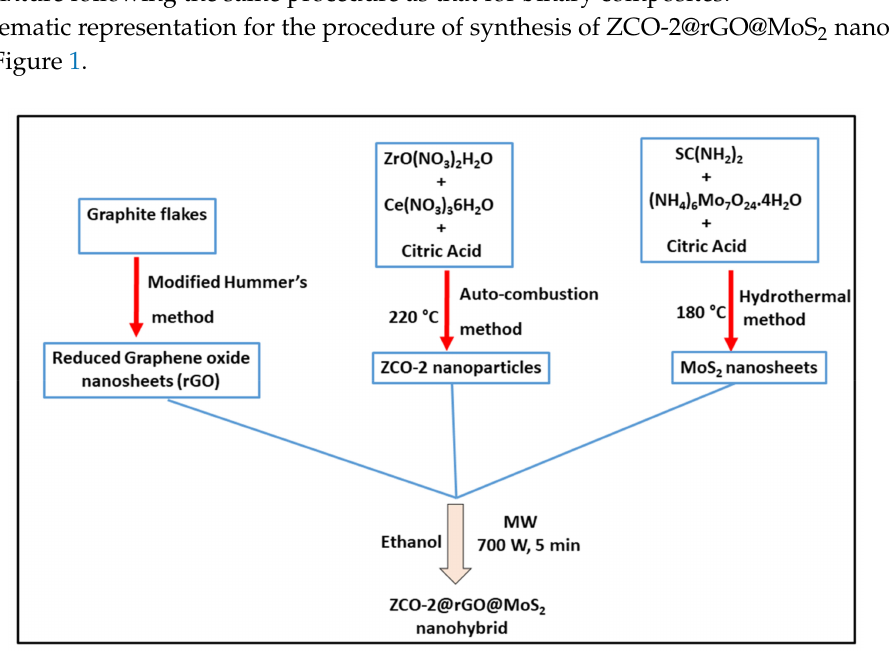
Schematic representation for the procedure of synthesis of ternary